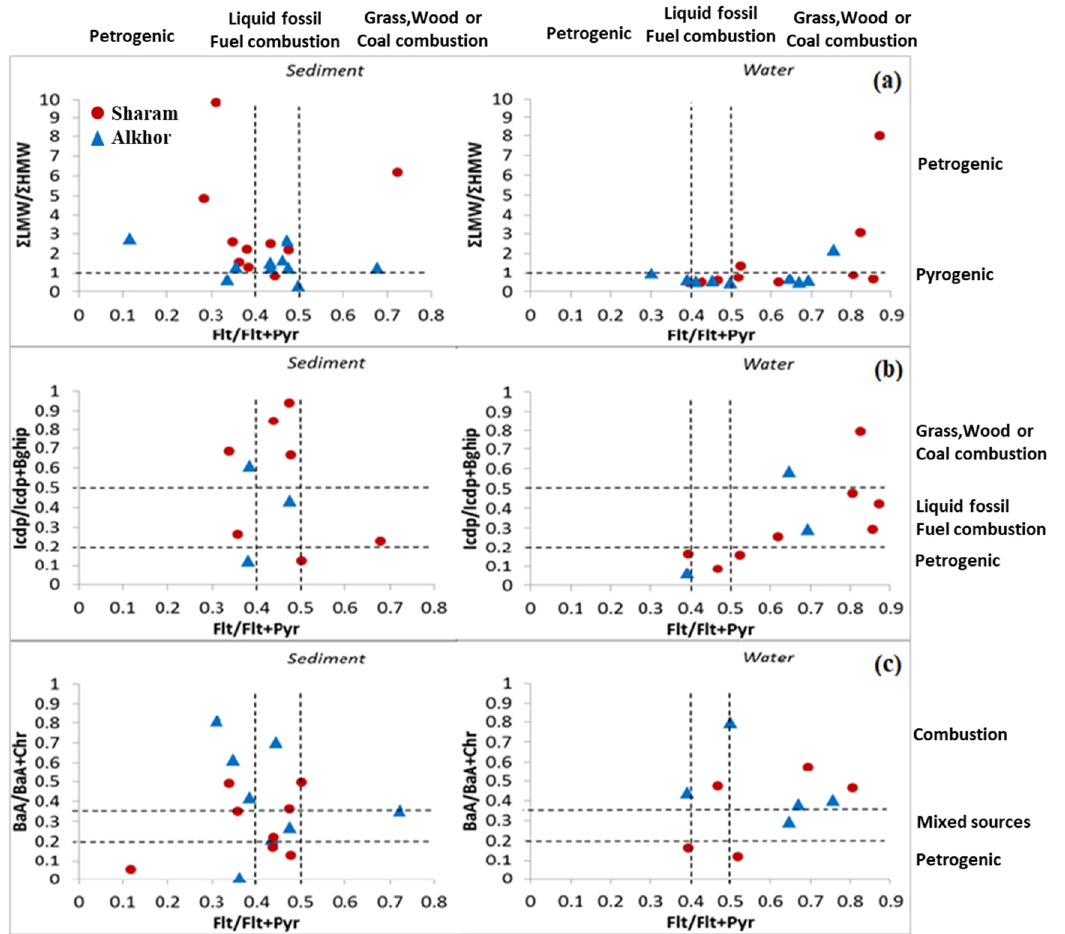
Figure 6. PAH cross plots of the diagnostic ratios used for both study areas: ( a ) the ratio PAH (L/H MW) vs. Flt/(Flt + Pyr), ( b ). the ratio IcdP/(IcdP + Bghip) vs. Flt/(Flt + Pyr), and ( c ) the ratio BaA/(BaA + Chr) vs. Flt/(Flt + Pyr).